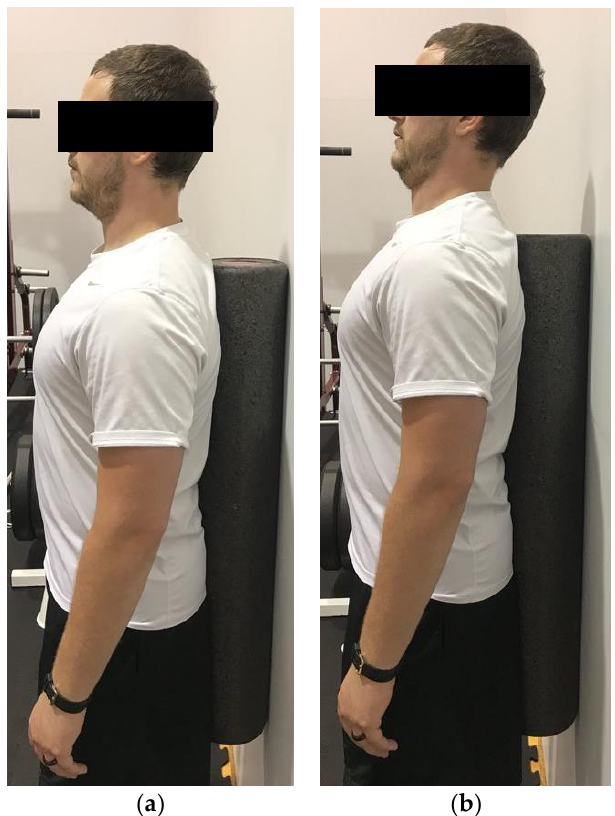
Figure 8. Demonstration of serratus push in the ( a ) start position; ( b ) end position. Hold the bar further than shoulder width. The goal is to avoid excessive horizontal adduction, while keeping the arms straight and pushing the bar upwards.